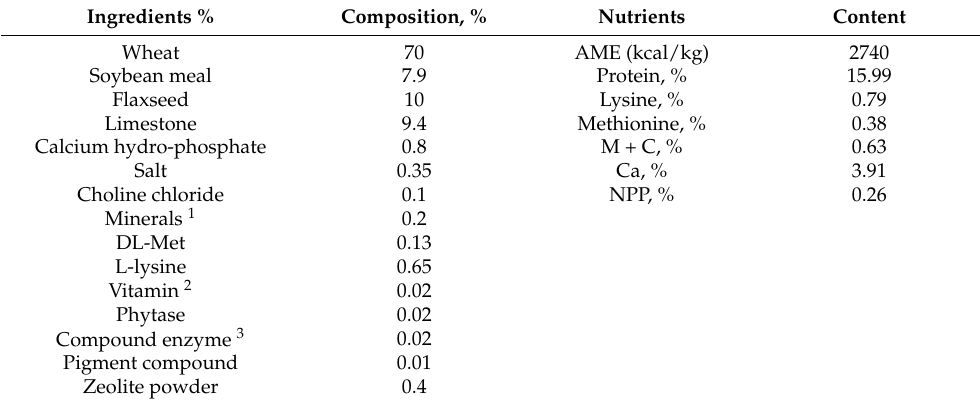
Figure 1. Graphical representation of the experimental scheme. C = control; VE 0.02% = vitamin E; CA 0.24% = chlorogenic acid; PF 0.05% = polyphenol; L 0.03% = lutein; FA profile = fatty acid profile. Table 1. Ingredients composition.